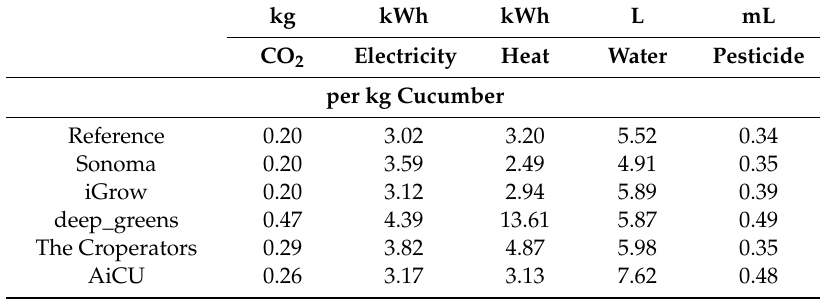
Table 1. Sustainability factors of different teams obtained per kg cucumber (fresh weight) during the experiment.